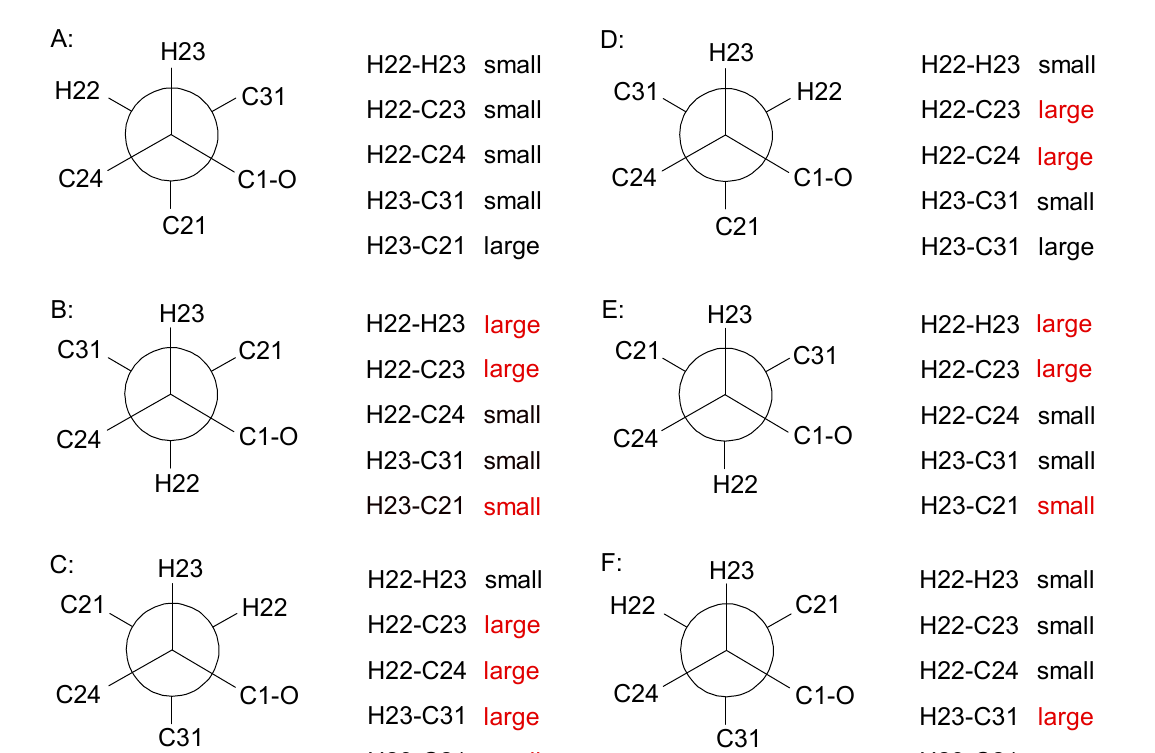
11 of 16 Figure 2. ( a ) Structure of morinagadepsin 1 . ( b ) selected 1 H, 1 H COSY (bold lines) and 1 H, 13 C HMBC (black arrows) correlations of 1 . After complete hydrolysis and derivatization with FDAA, we observed L -Leu, L -Val, and L -Ala according to Marfey’s method [36]. Thus, C-2, C-8, C-11, and C-17 are S -config- urated. The relative configurations of the chiral centers C-22/C-23 in HMDA was deter- mined by J -based configurational analysis using 3 J HH , 2 J CH , 3 J CH and ROESY correlations (Figure 3) as 22 R *,23 R *. Necessary proton-carbon coupling constants were obtained from a HSQC-Hecade NMR spectrum (Figure S10), except 3 J(H23,C21) = 6.6 Hz, which was ex- tracted from a J -HMBC NMR experiment (Figure S11) [40].